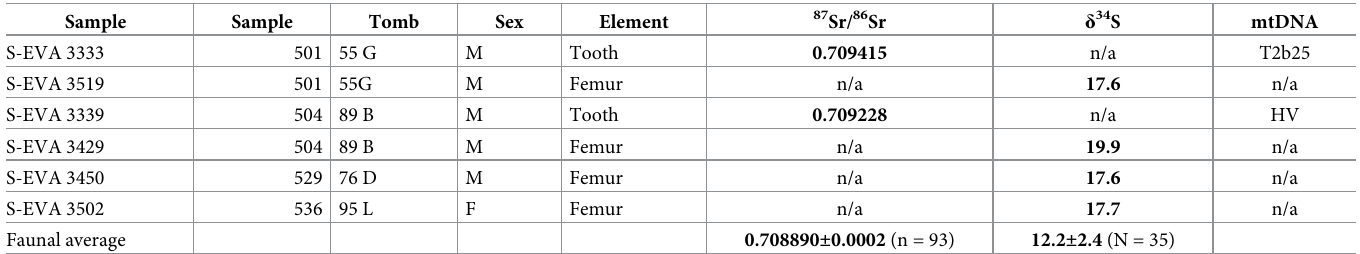
The DNA preservation was overall rather poor, with the percentage of endogenous human DNA in every sample between 0.01 and 0.18 (Table 6). Due to the low yield of human shotgun reads, the genetic sex could not be determined. Nevertheless, the mitochondrial capture resulted in 10 complete or nearly complete mtDNA genomes, with reads showing patterns of C-to-T and G-to-A misincorporations at the 5’ and 3’ ends, respectively, which are typical of Table 3. Sulphur, strontium and mtDNA results from four humans with isotope values outside the range of local faunal values for Crete. These individual with ‘non-local’ values are from the Late Bronze Age site or Armenoi, Crete. Also included are the average strontium and sulphur faunal values from this study.